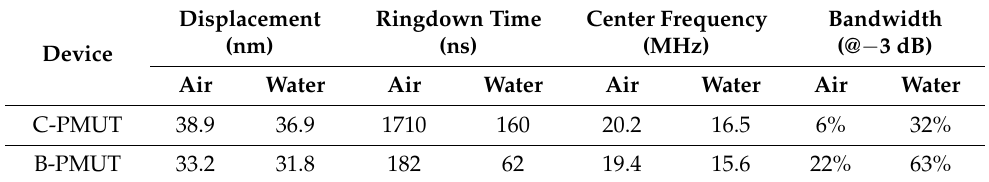
Figure 7. Vibration response of ( a ) C-PMUT and ( b ) B-PMUT, tested in water with a 10 ns 30 V pulse. The time-domain response is shown with a red solid line, and the frequency-domain response is shown with a blue dash line. Table 2. Impulse responses of C-PMUT and B-PMUT.